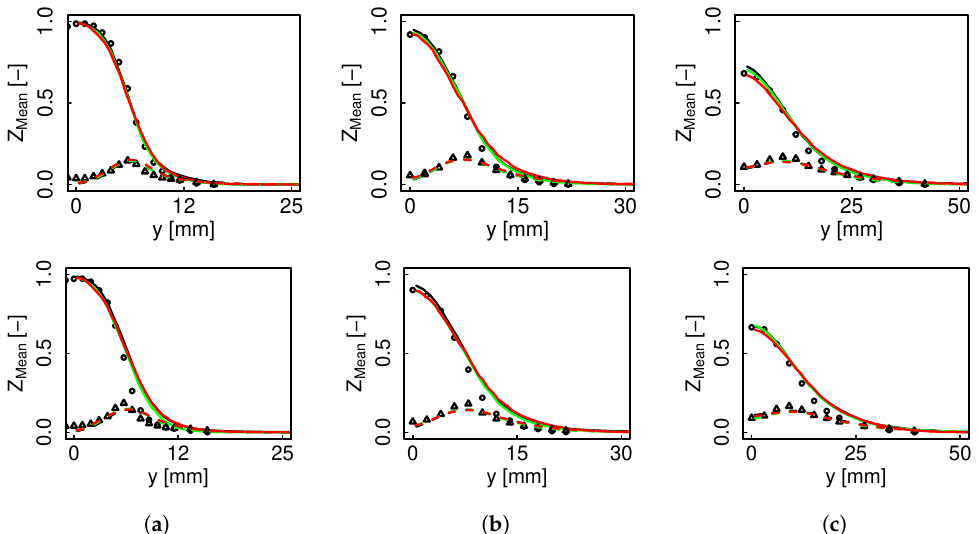
Figure 6. Mixture fraction mean and RMS radial profiles for flame D ( top ) and E ( bottom ). Black color represents non-premixed FTACLES, green color premixed FTACLES, red color FPV, solid line mean, dashed line RMS. Circles depict experimental mean, and triangles experimental RMS. ( a ) x / d = 7.5; ( b ) x / d = 15; ( c ) x / d =